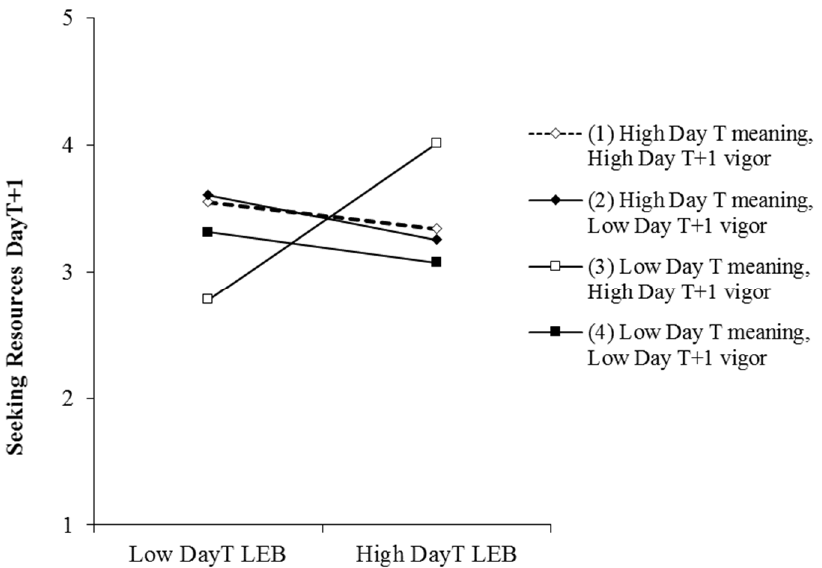
Figure 2. Moderating e ff ect of employee day T work meaning and day T + 1 vigor on the relationship between day T leader empowering behaviors (LEB) and employee day T + 1 seeking resources.